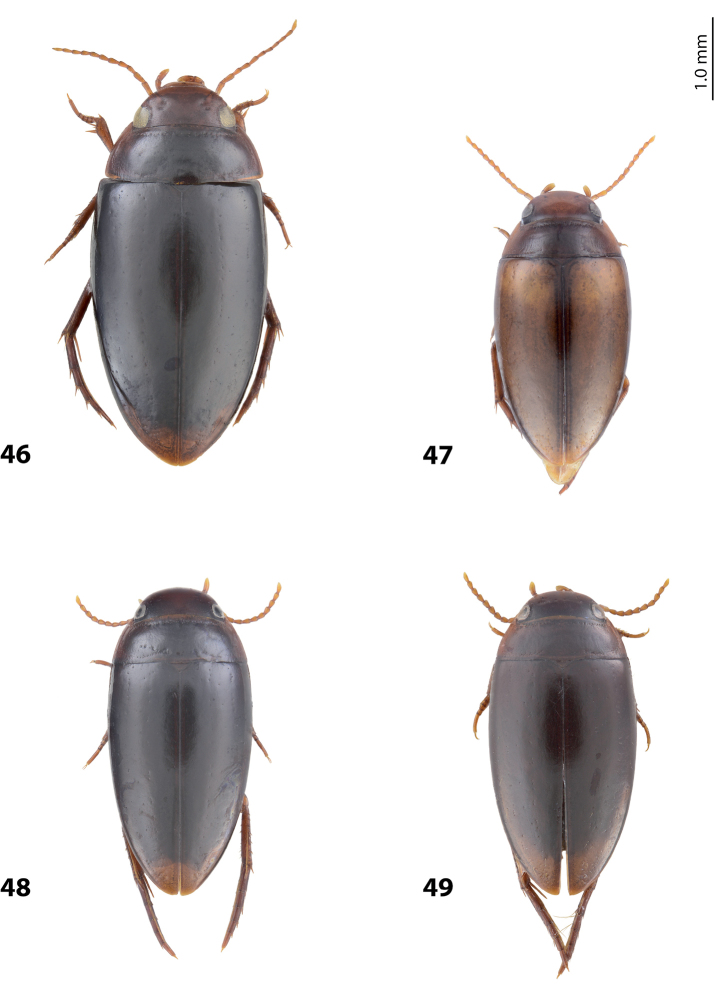
Habitus and colouration 46Exocelina
kobau sp. nov. 47E.
pulchella sp. nov. 48E.
warasera sp. nov. 49E.
haia sp. nov.